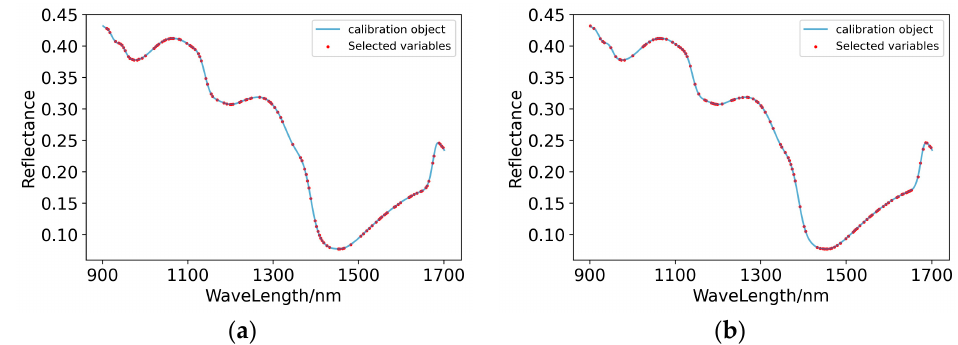
Figure 10. Characteristic wavelengths’ distribution of prediction models for the content of potas- in pear pulp. ( a ) Raw-GA-PLSR; ( b ) SG-GA-PLSR.